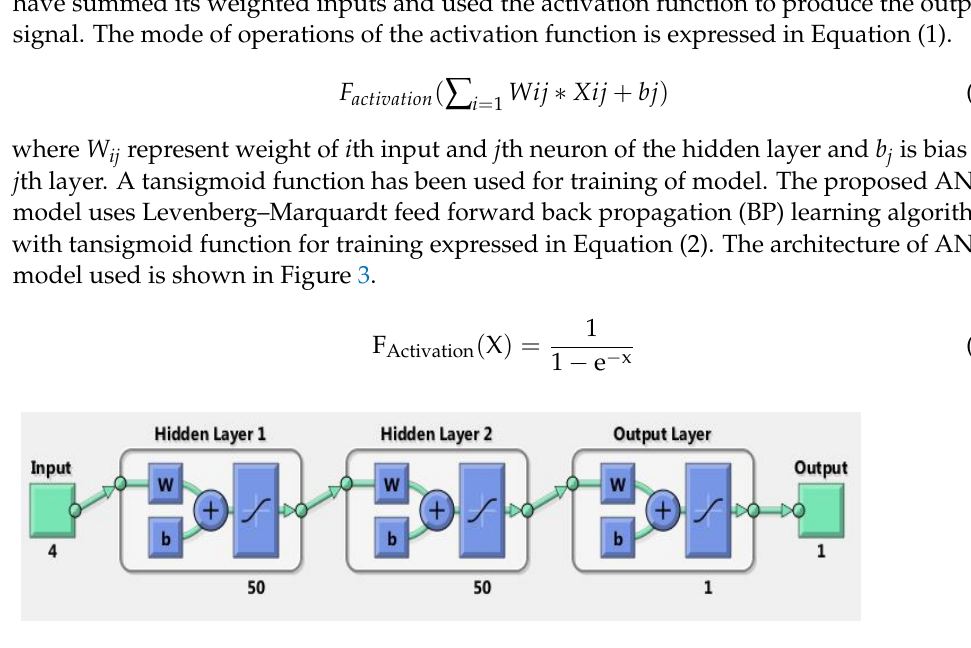
Figure 3. Architecture of ANN.